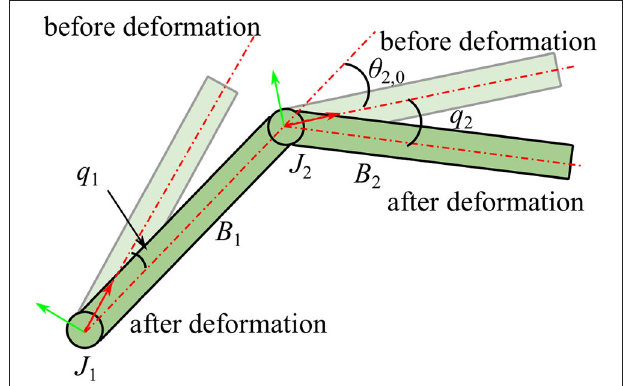
FIGURE 2 | Coordinate system of the